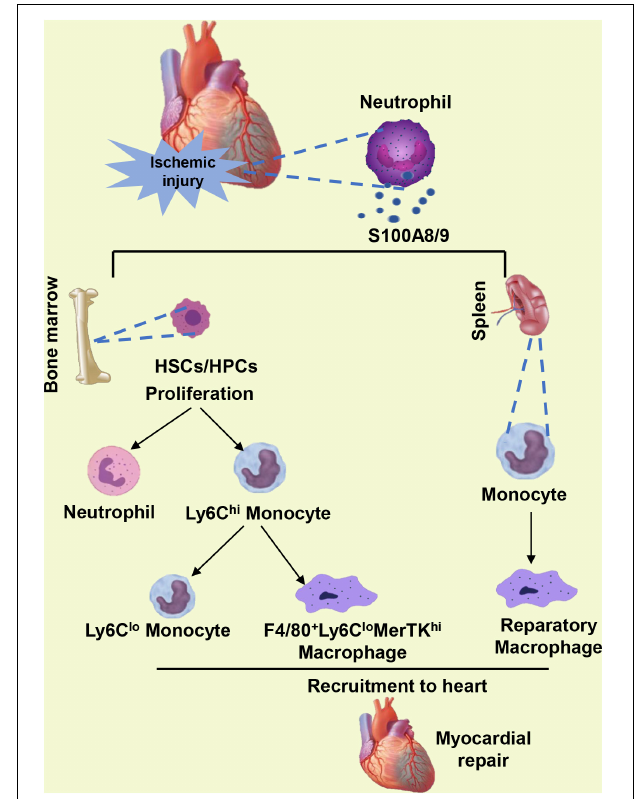
FIGURE 2 | When ischemic injury occurs, neutrophils infiltrating the heart secrete S100A8/A9. S100A8/A9 facilitates the proliferation of HSCs and HPCs in the bone marrow and the differentiation of inflammatory Ly6C hi monocytes into reparatory Ly6C lo monocytes or reparatory F4/80 + Ly6C lo MerTK hi macrophages. Furthermore, S100A8/A9 in the reparatory phase also promotes the mobilization of monocytes from the splenic reservoir to the ischemic myocardium and boosts their transformation into reparatory